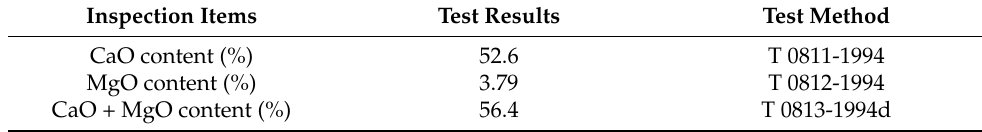
Table 2. Physical and chemistry properties of lime.